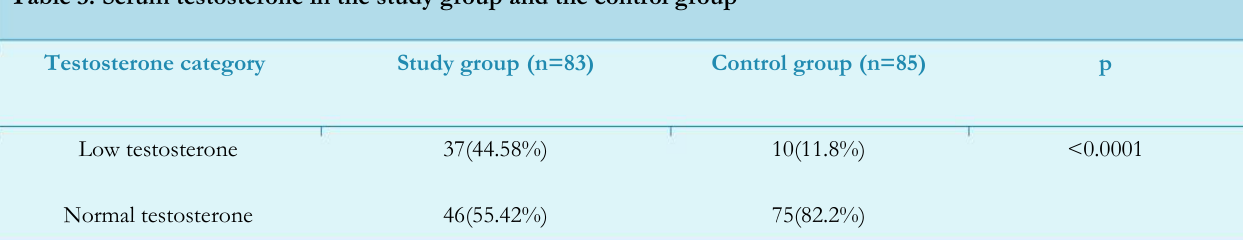
The relationship between serum testosterone levels and microvascular complications of diabetes mellitus was evaluated. Continuous variables were compared using ‘t’ test for independent variables and Chi-square test was applied on categorical